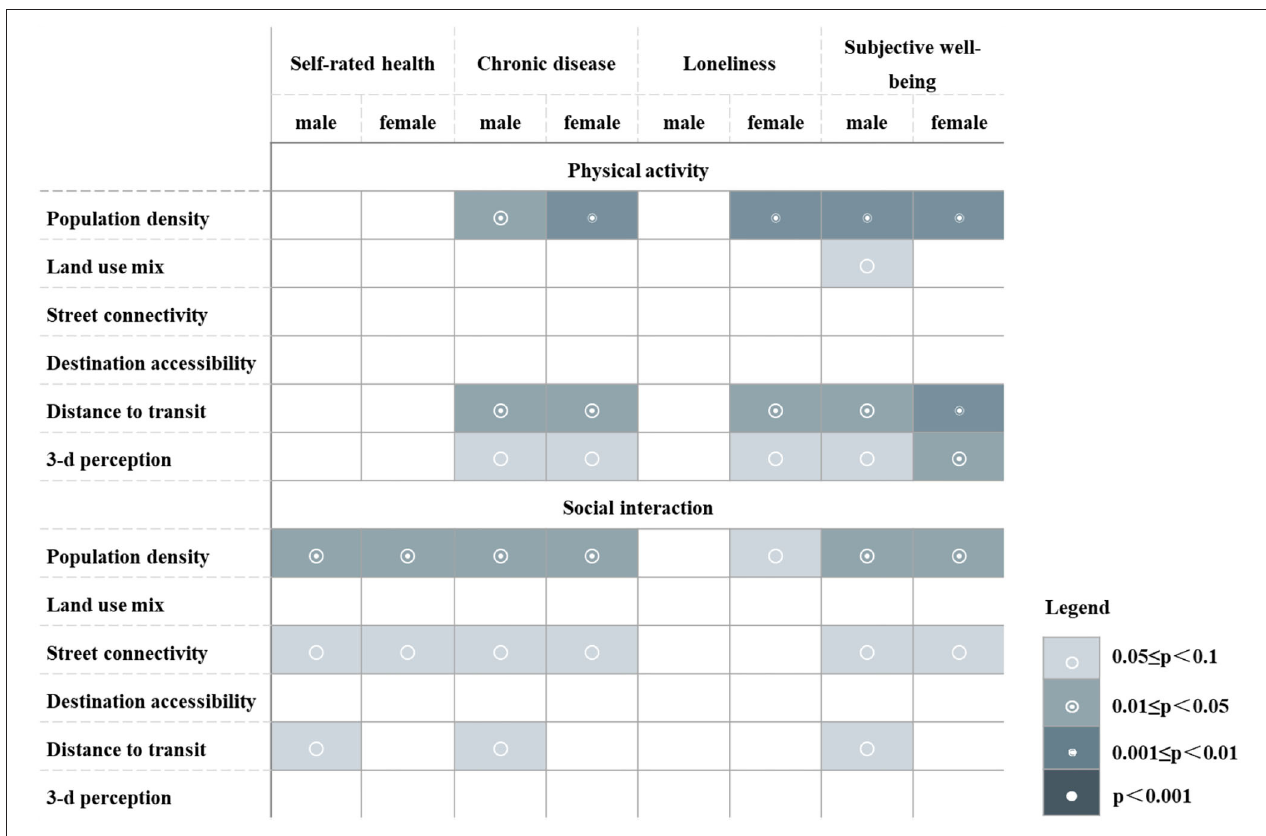
FIGURE 2 | Gender heterogeneity of mediating effects of neighborhood-built environment on elderly